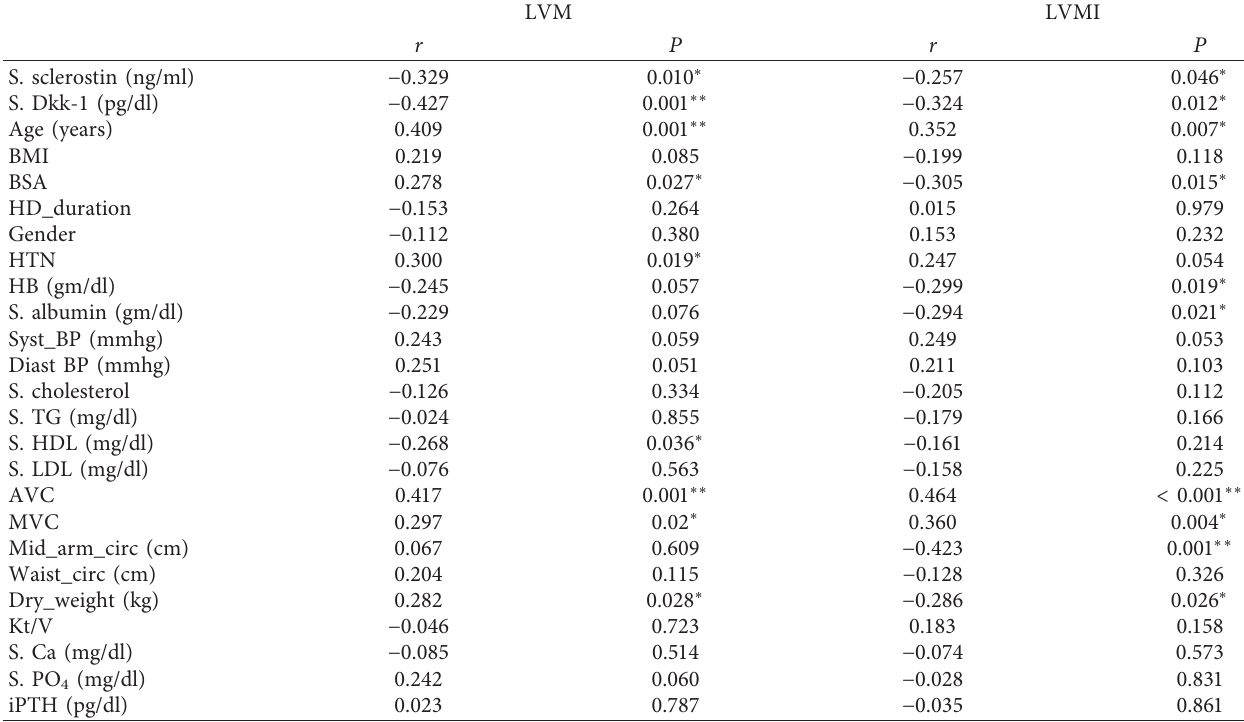
Table 4: Correlation between LVM and LVM/BSA and some demographic and laboratory parameters among the studied subgroups.